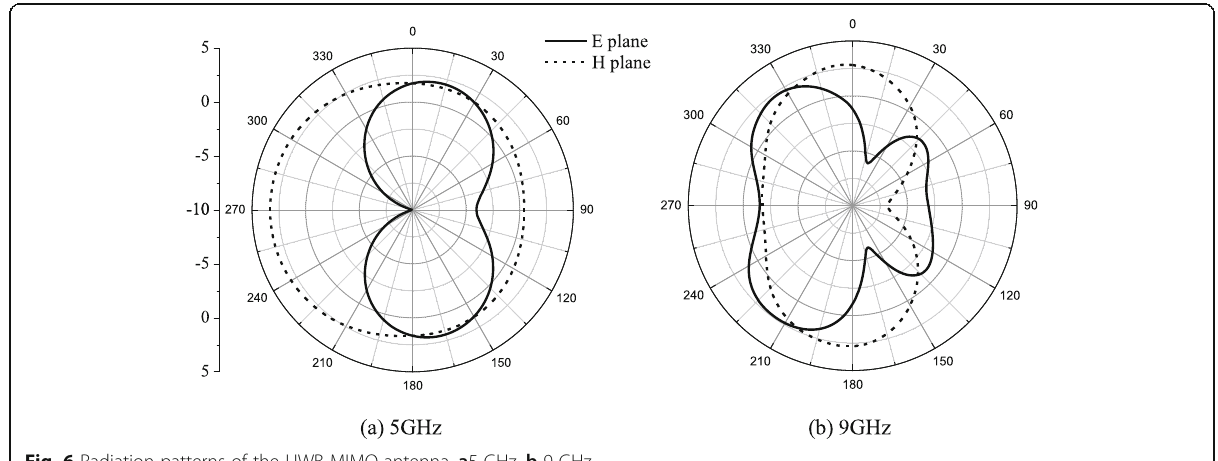
Fig. 6 Radiation patterns of the UWB-MIMO antenna. a 5 GHz. b 9